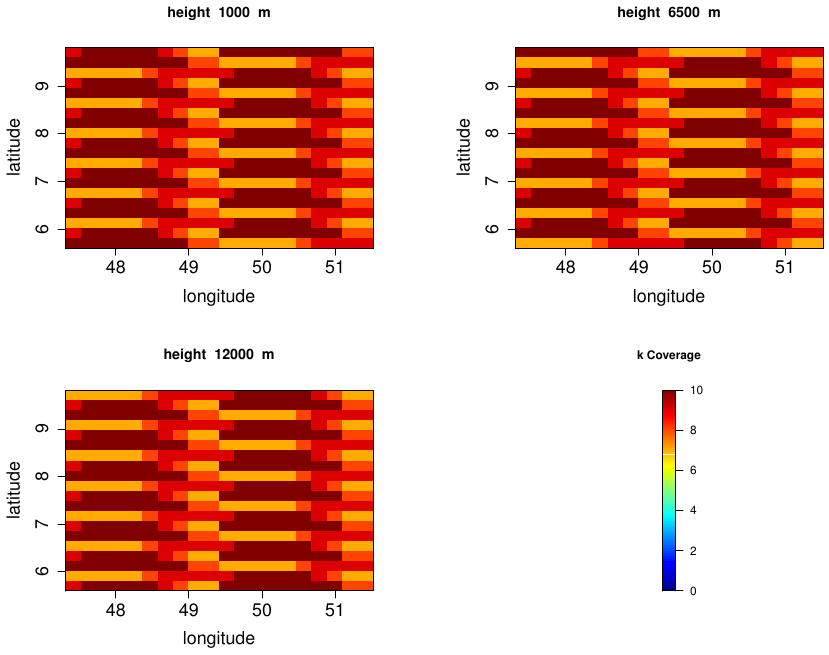
Figure 3. Simulated k-coverage heatmap for optimal placement of ADS-B sensors after solving scenario